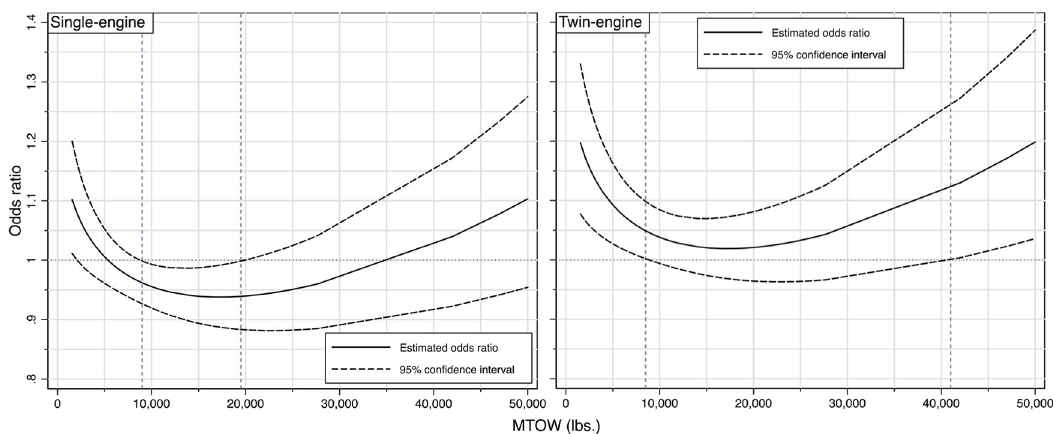
Fig 5. The odds ratio for 1 ft. (0.305 m) increase in rotor diameter among turboshaft helicopters.